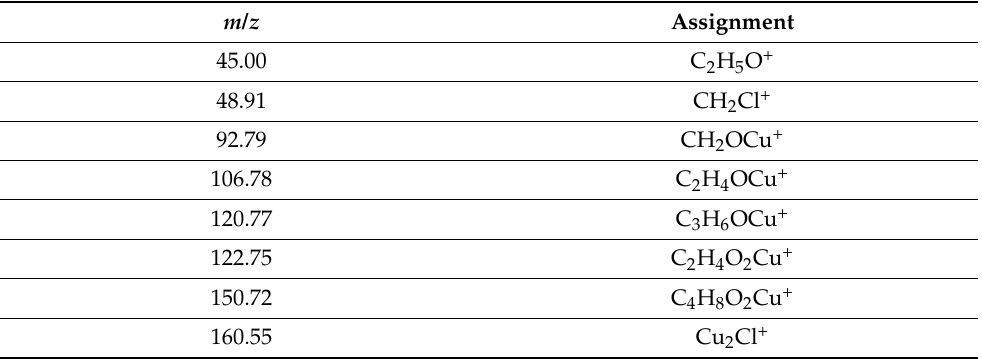
Table 1. The assignment and m / z (mass to charge) of the most distinct positive fragments identified in the TOF-SIMS mass